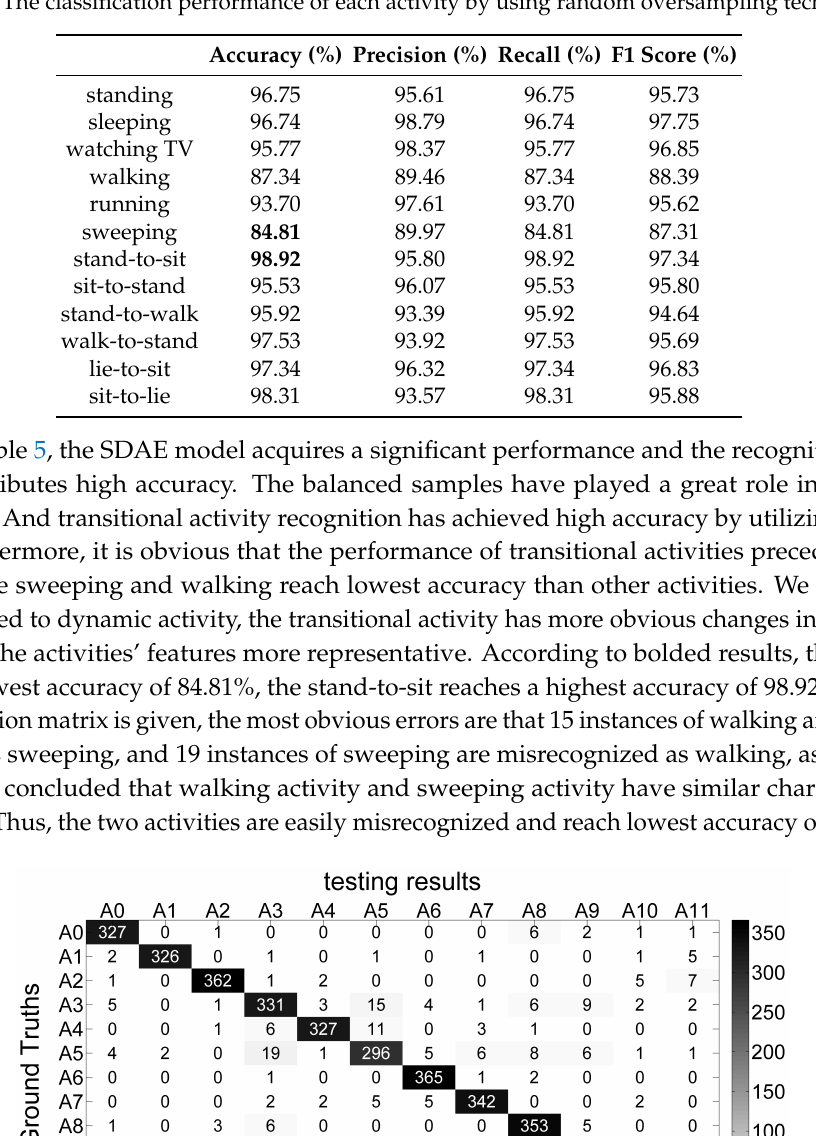
Table 5. The classification performance of each activity by using random oversampling technique.